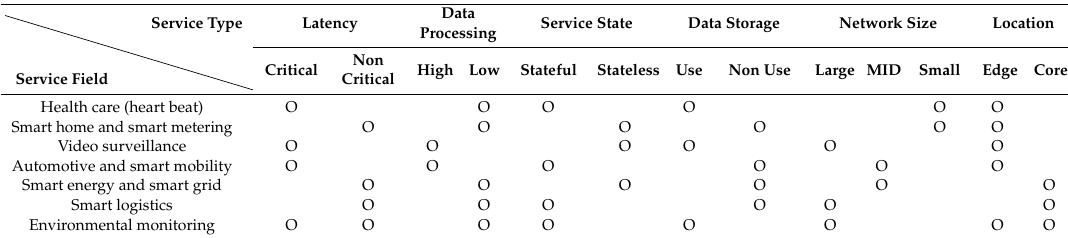
Table 1. Internet of Things (IoT) service